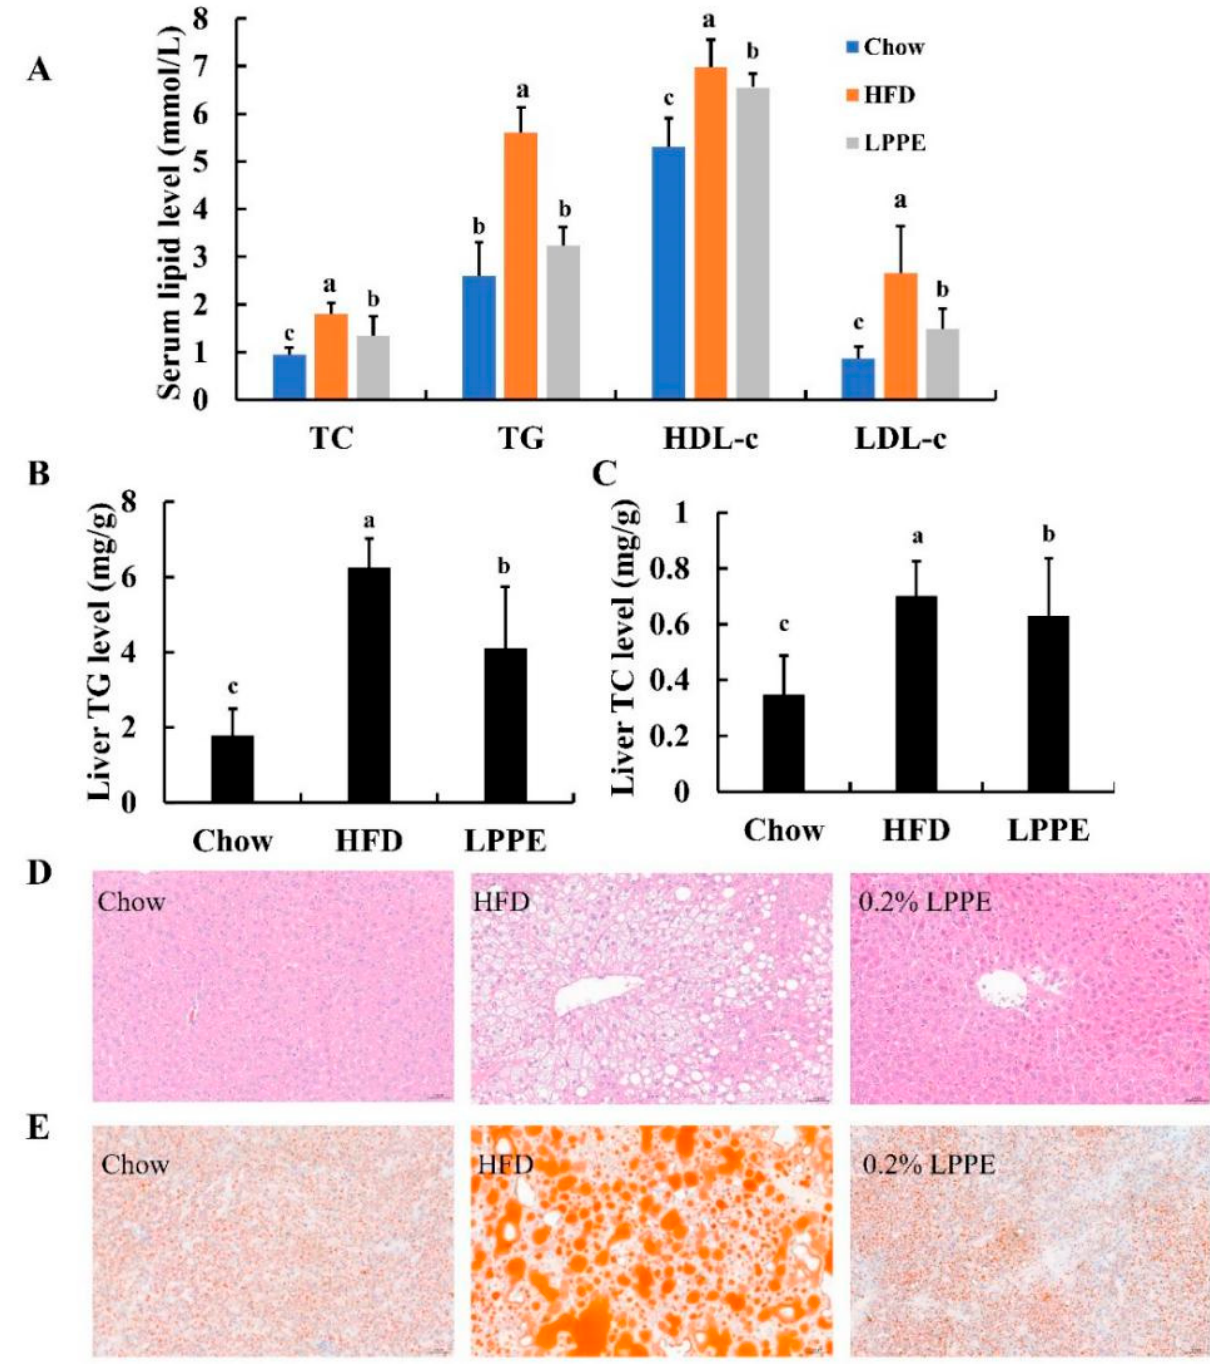
Figure 3. Effects of LPPE on serum and liver lipids, and hepatic steatosis in high-fat diet-induced- obese mice. ( A ) Serum TC, TG, HDL-c, and LDL-c. ( B ) Hepatic TG level. ( C ) Hepatic TC level. ( D ) H&E staining ( × 200) of hepatic tissues. ( E ) ORO staining ( × 200) of hepatic tissues. Values are expressed as the mean ± SEM (n = 8). Different letters above the bars with the same color index indicate significant differences ( p < 0.05).